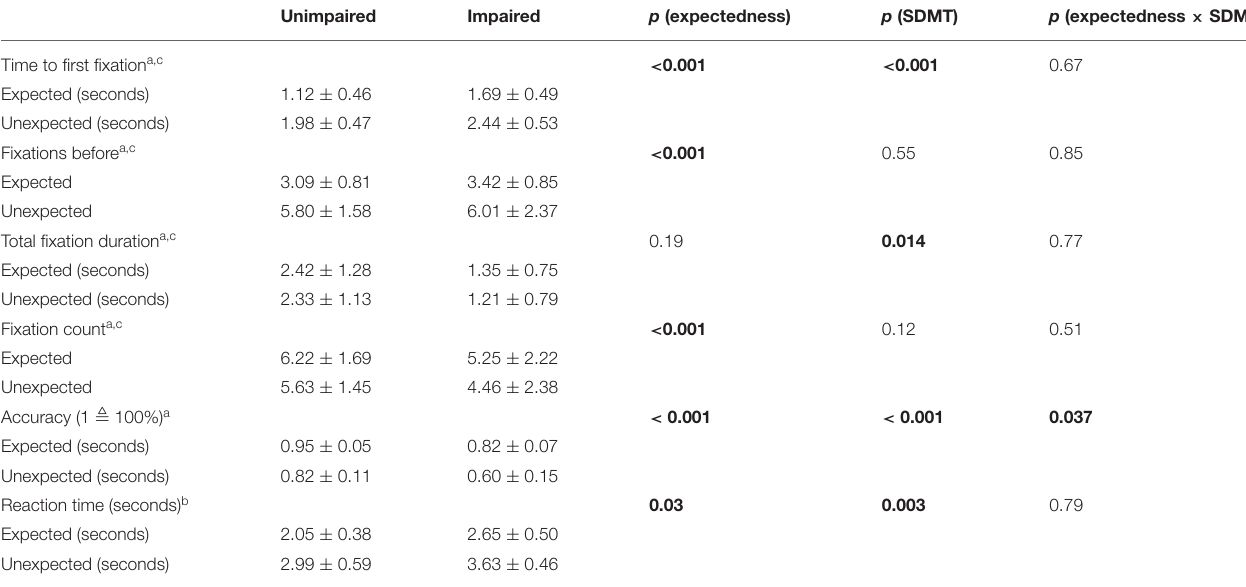
TABLE 4 | Visual search behavior depending on SDMT and expectedness of the location of the target.